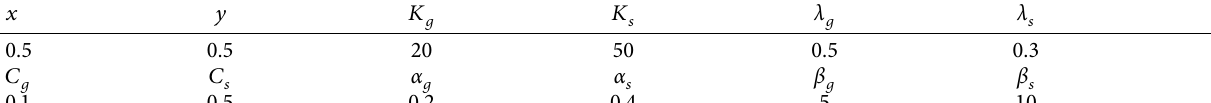
Table 4: The initial values of parameters.